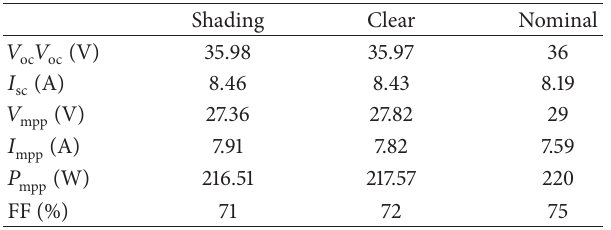
Table 6: Key parameters of the PV modules shaded by bird litter under